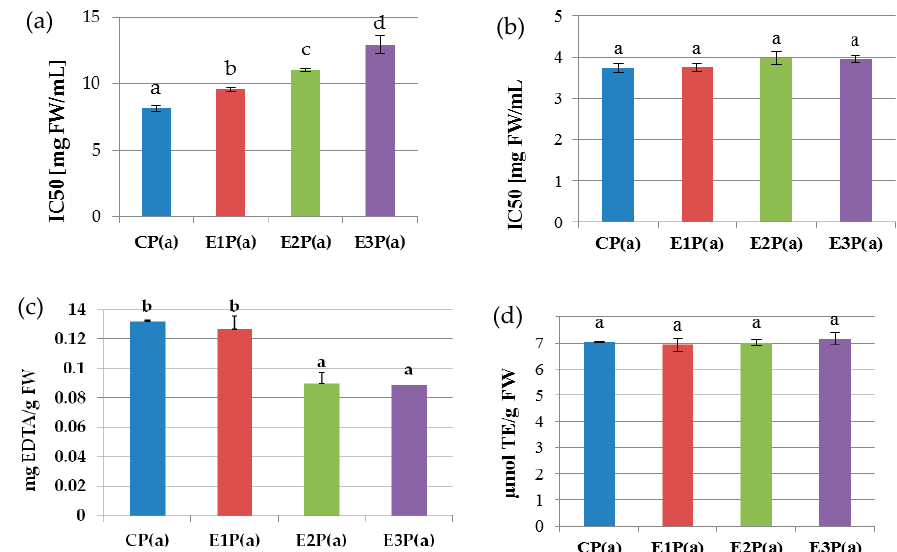
Figure 1. Antioxidant properties of purified anthocyanin fractions from pomace made from raspberries subjected to enzymatic maceration: ( a ) ability to neutralize DPPH • radicals ( b ) ability to neutralize the radicals of ABTS • + , ( c ) ability to chelate iron ions, ( d ) reduction power (FRAP). Mean values marked with the same letters do not di ff er significantly in terms of p ≤ 0.05. Symbols: CP(a)—purified anthocyanin fraction from pomace obtained from control raspberry pulp; E1P(a)—purified anthocyanin fraction from pomace obtained from raspberry pulp macerated with Pectinex Ultra SP-L; E2P(a)—purified anthocyanin fraction from pomace obtained from raspberry pulp macerated with Pectinex Yield-Mash; E3P(a)—purified anthocyanin fraction from pomace obtained from raspberry pulp macerated with Ultrazym